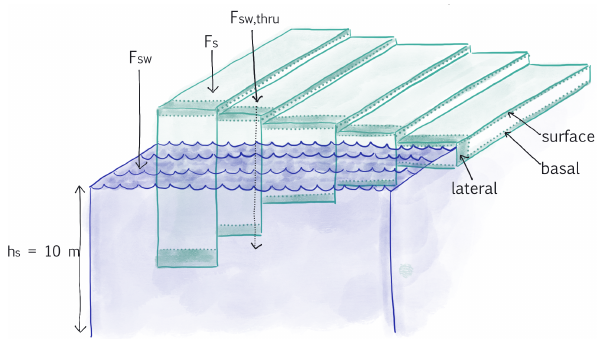
Figure 1. Schematic of key components of a model grid cell in the CICE sea ice model, including the five-category ice thickness dis- tribution, and important fluxes and melt terms. Based on schematics from Notz and Bitz (2017) and Petty et al.